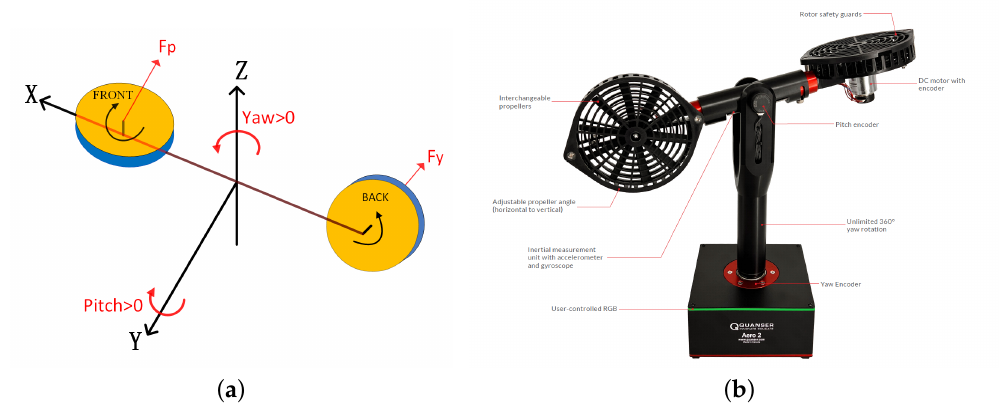
Figure 1. Schematic diagram of a 2-DOF helicopter. 2-DOF helicopter platform structure ( a ) schematic diagram ( b ) physical picture. Table 1. System variables and description of